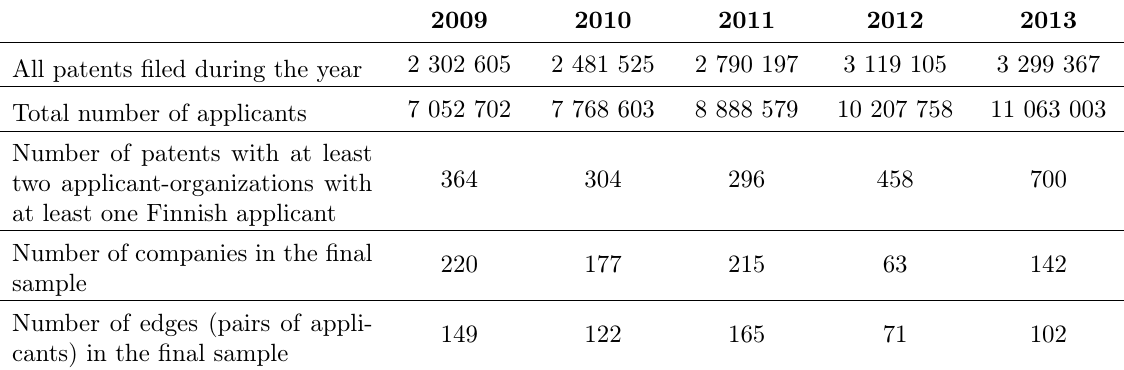
Table 2. Joint patent sample data.